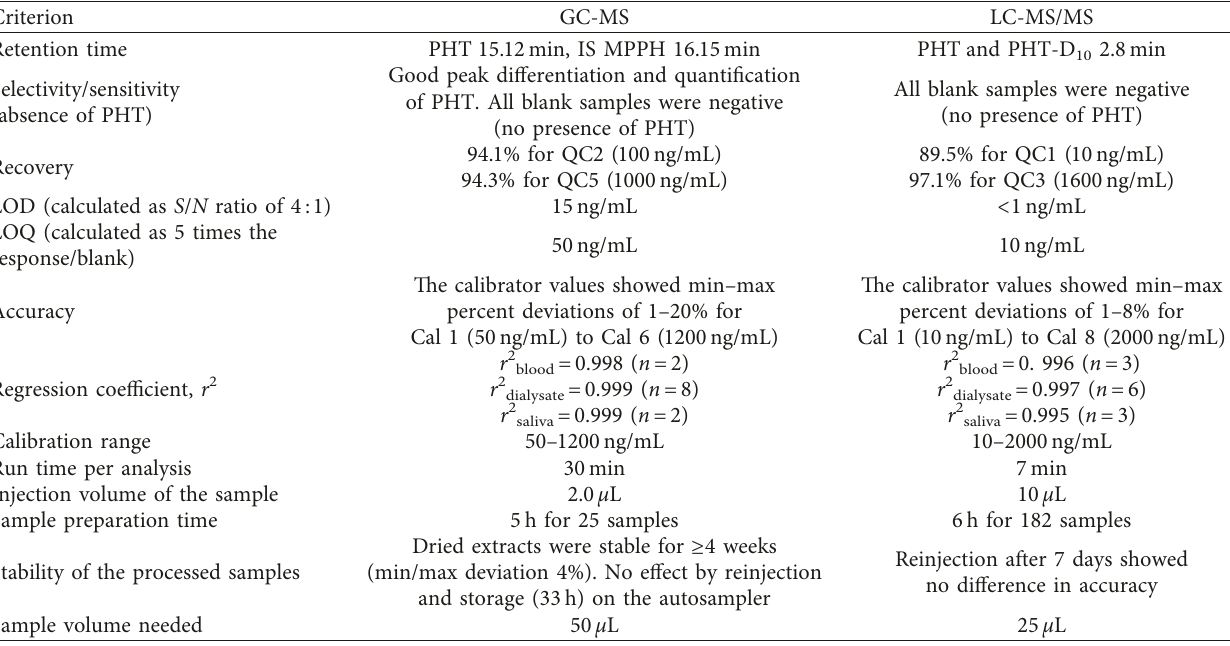
Figure 3: Chromatogram of phenytoin (illustrated for LOQ (10ng/mL) and QC3 (400 ng/mL)) with PHT-D Table 2: Comparison of the GC-MS [8] versus LC-MS/MS